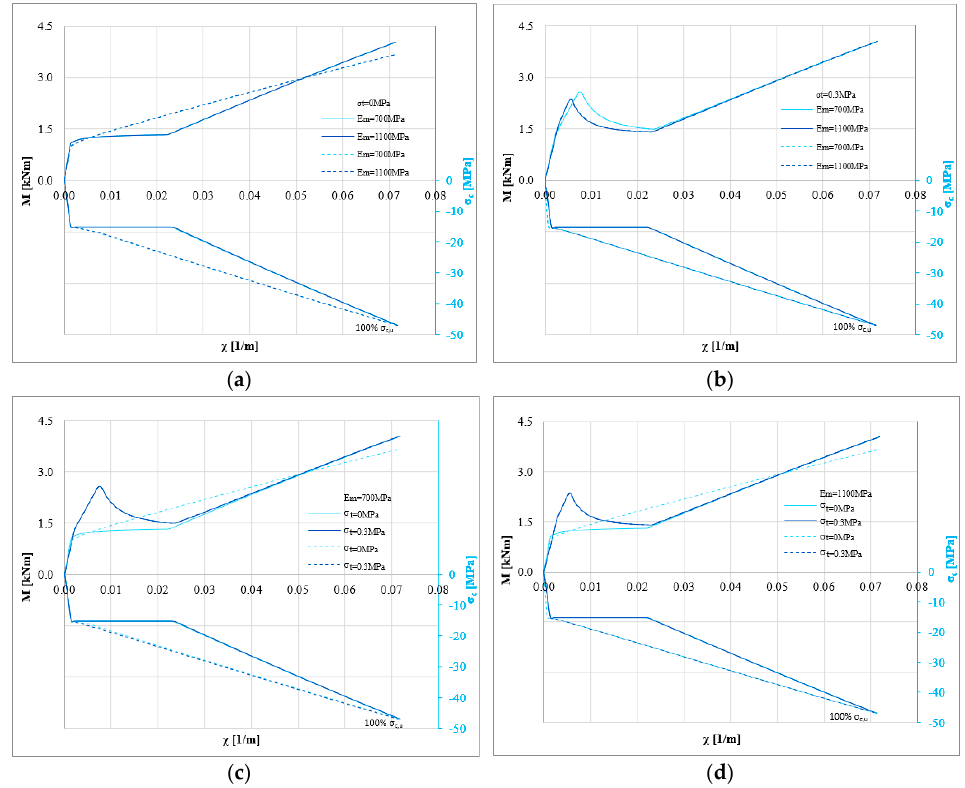
Figure 7 . M- χ and σ c,u - χ diagrams: P = 0 N, σ 0 = 1 MPa, σ t = 0 and 0.3 MPa, E m = 700 and 1100 MPa for tri-linear (solid lines) and bi-linear (dotted lines) relationships for the strengthening system (hemp fiber): ( a ) σ 0 = 1 MPa, σ t = 0 MPa changing E m ( b ) σ 0 = 1 MPa, σ t = 0.3 MPa to changing E m ( c ) σ 0 = 1 MPa,